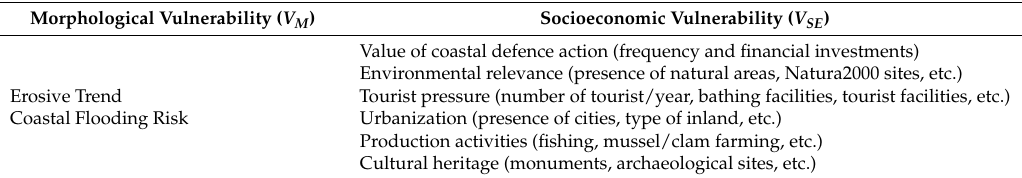
Table 1. Description of terms V M and V SE in Equation